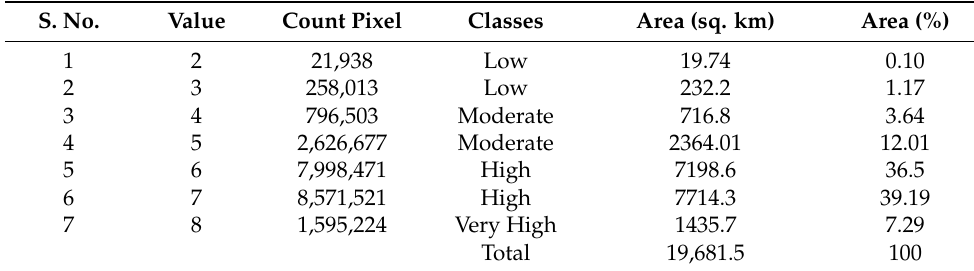
Figure 15. Pie chart showing groundwater potential in the study region. Table 8. Pixel-based analysis for ground water potential (30 m).